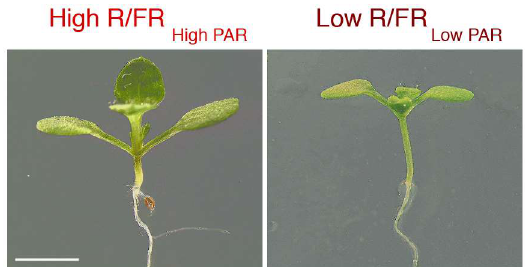
Figure 1. Shade avoidance phenotypes in Arabidopsis seedlings. Seedlings were grown for four days in high red (R)/far-red (FR) High PAR and then either maintained in the same light regime or transferred to low R/FR Low PAR for six days in a 16-h light/8-h dark photoperiod to simulate, respectively, sunlight and shade. Light outputs were as previously reported [9]. Scale bar, 2 mm.